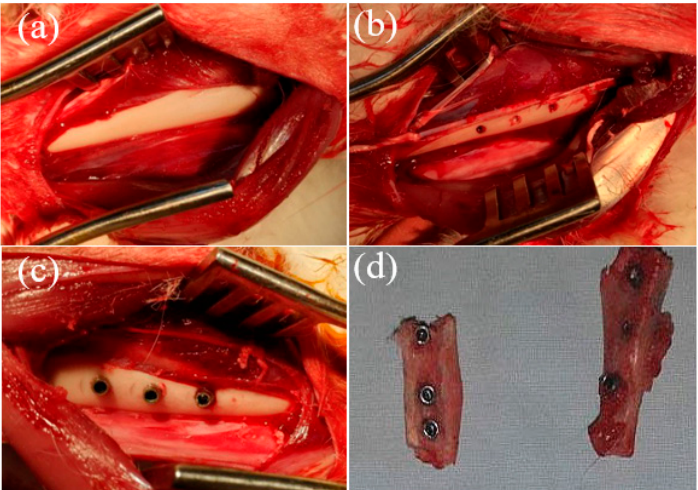
Figure 1. Surgical procedures showing ( a ) incision and peeling; ( b ) preparation of implantation sites using a guide drill and twist drill; ( c ) implant replacement where Ti64/SA implants were placed on the right side, while Ti64/7 ion implants were placed in the left side; and ( d ) the scarified sample taken after 8 weeks of the experiments.